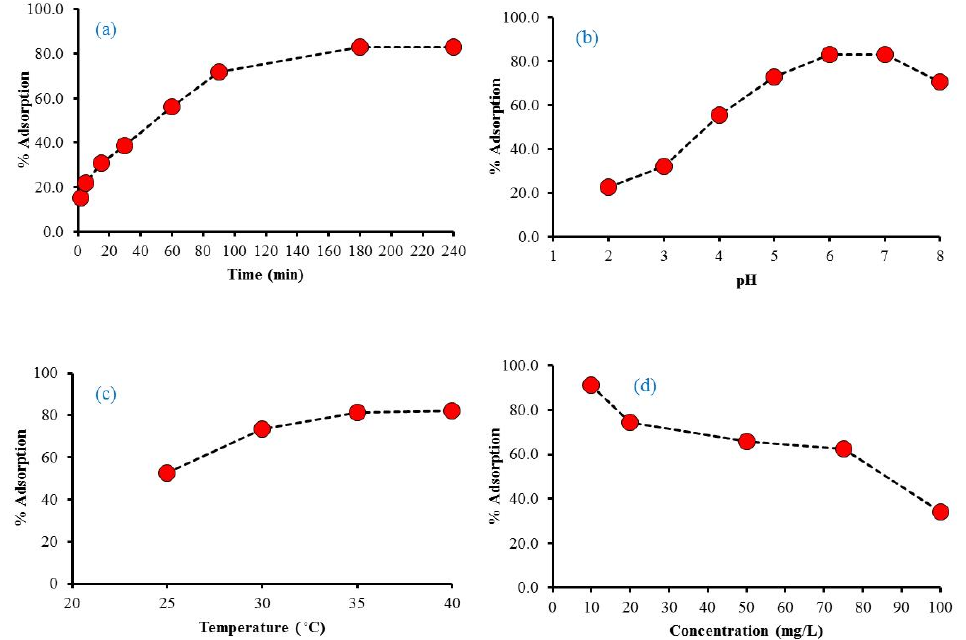
Figure 4. Effect of influential parameters on the adsorption of cadmium ions ( a ) Contact time, ( b ) solution pH, ( c ) temperature, and ( d ) concentration of adsorbate .